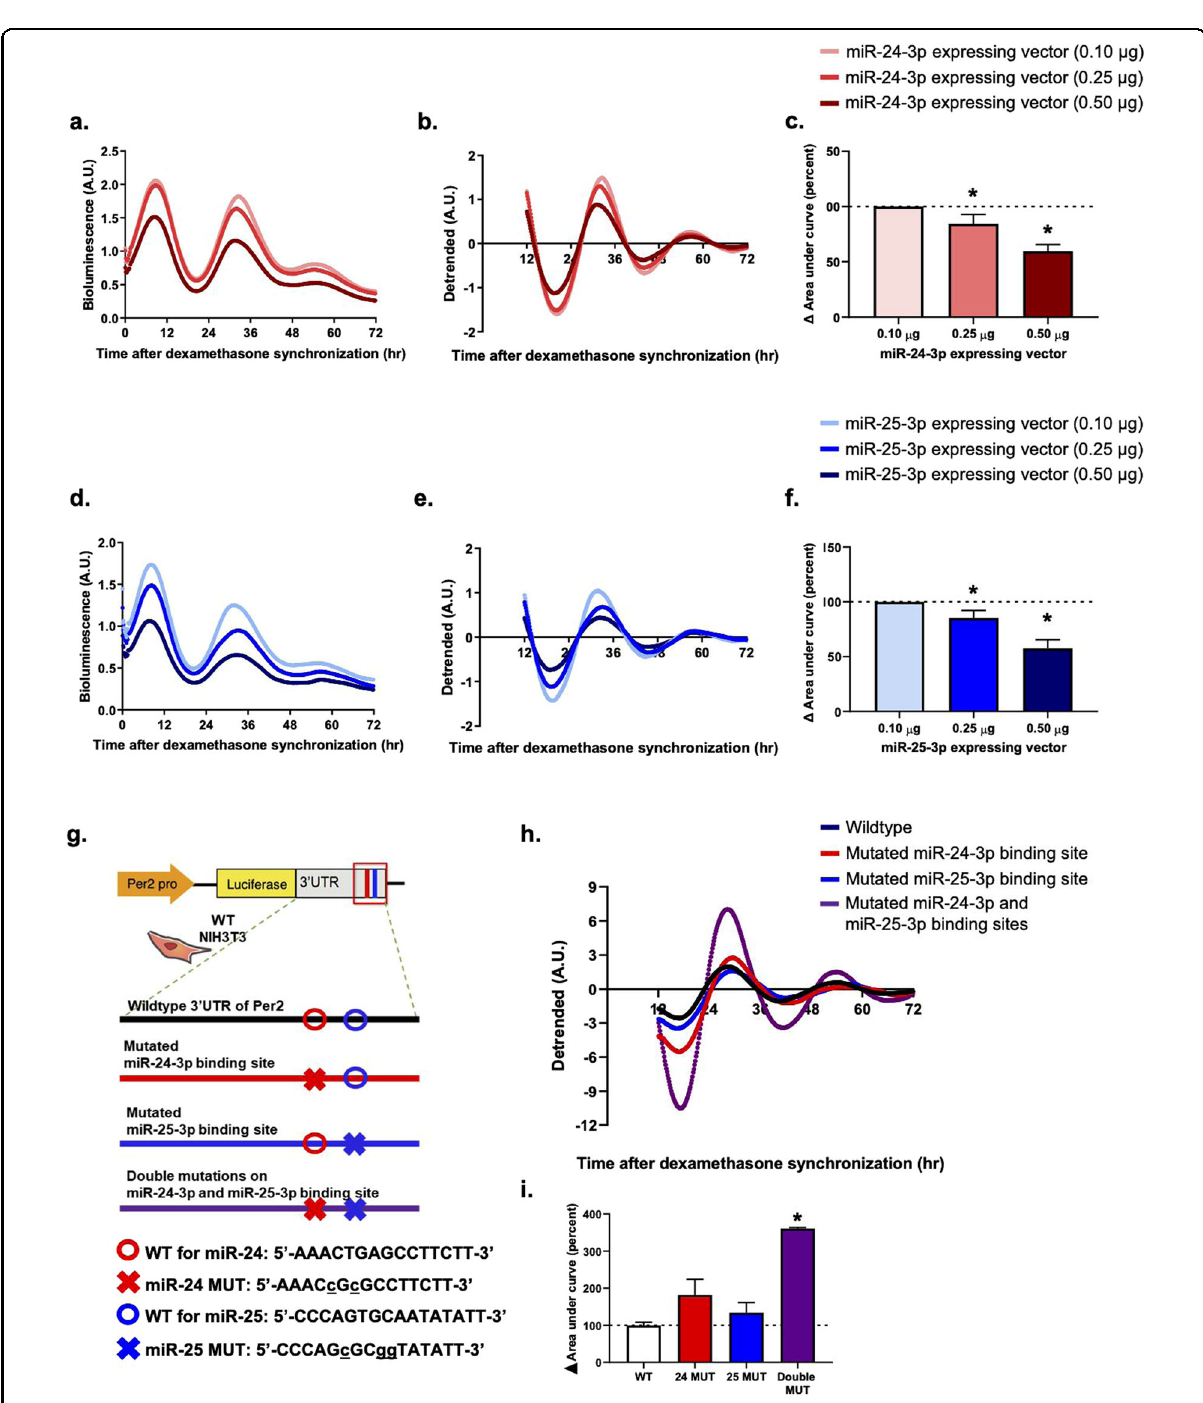
Fig. 4 miR-24-3p and miR-25-3p functioned in a dose-dependent manner and bind to their speci fi c sites on the 3 ′ -UTR of Per2 . Real-time bioluminescence recordings of PER2::LUC oscillation in Per2::Luc KI MEFs that were transfected with a , b miR-24-3p-overexpressing vectors or d , e miR-25-3p-overexpressing vectors in a dose-dependent manner. c , f The area under the curve was calculated from the raw data, which is presented in bar graphs. g Schematic for designed site-directed mutations of the miR-24-3p- and/or miR-25-3p binding sites on the 3 ′ -UTR of Per2 in the pGL3- LUC vector driven by the Per2 promoter. h Results of the real-time bioluminescence recordings of the transfected site-directed mutated luciferase vectors in the NIH3T3 wild-type fi broblasts and i the area under curve was calculated, which is presented in bar graphs. Data are presented as the means ± SE ( n = 3), and signi fi cance was assessed by one-way ANOVA, * p < 0.05 compared to the control